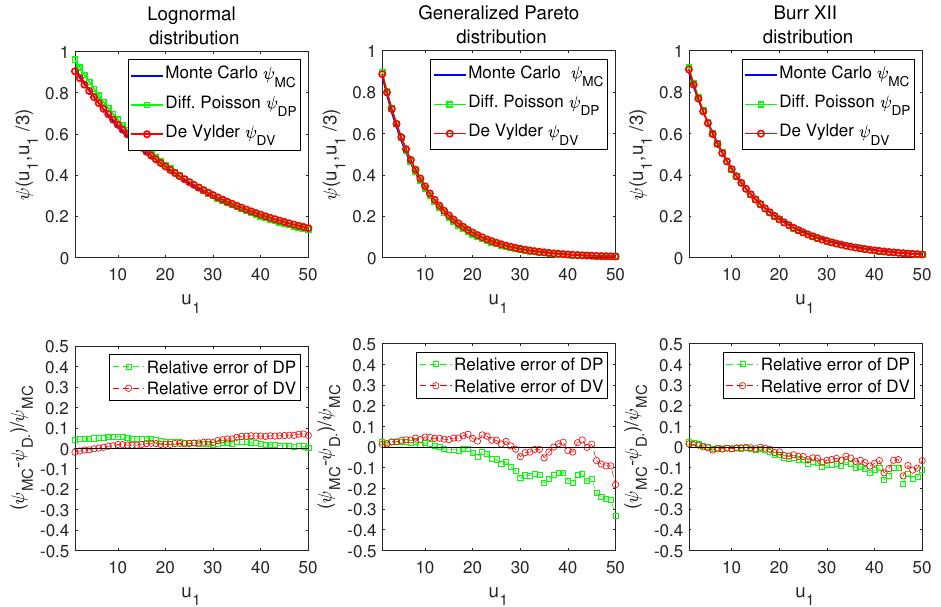
Figure 6. Ruin probabilities ( top panels) for the insurer–reinsurer model in the infinite-time horizon calculated using Monte Carlo (MC) simulations with the Poisson process with λ = 10, the diffusion approximation with the Poisson process (DP) and the De Vylder-type approximation (DV) for selected heavy-tailed distributions. Respective relative errors ( bottom panels) of the approximations. In the simulations, the number of MC iterations is 10,000, parameters of claim distributions are given by Equations